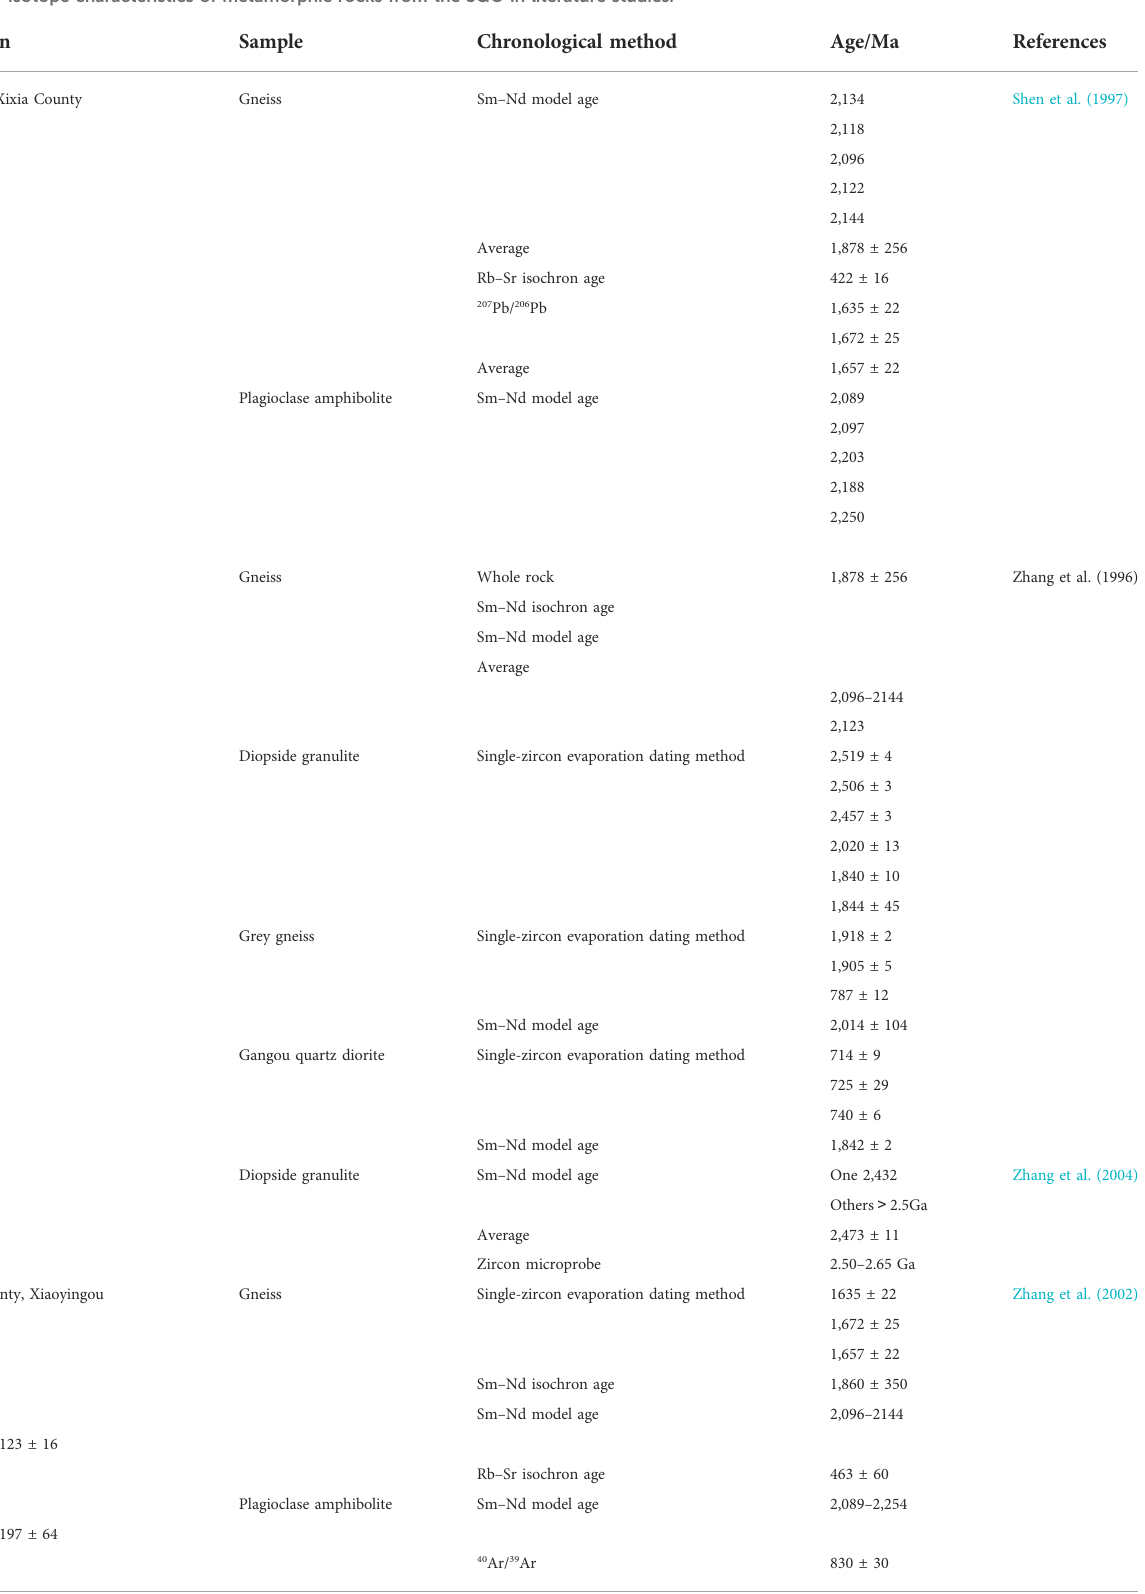
TABLE 4 Isotope characteristics of metamorphic rocks from the SQO in literature